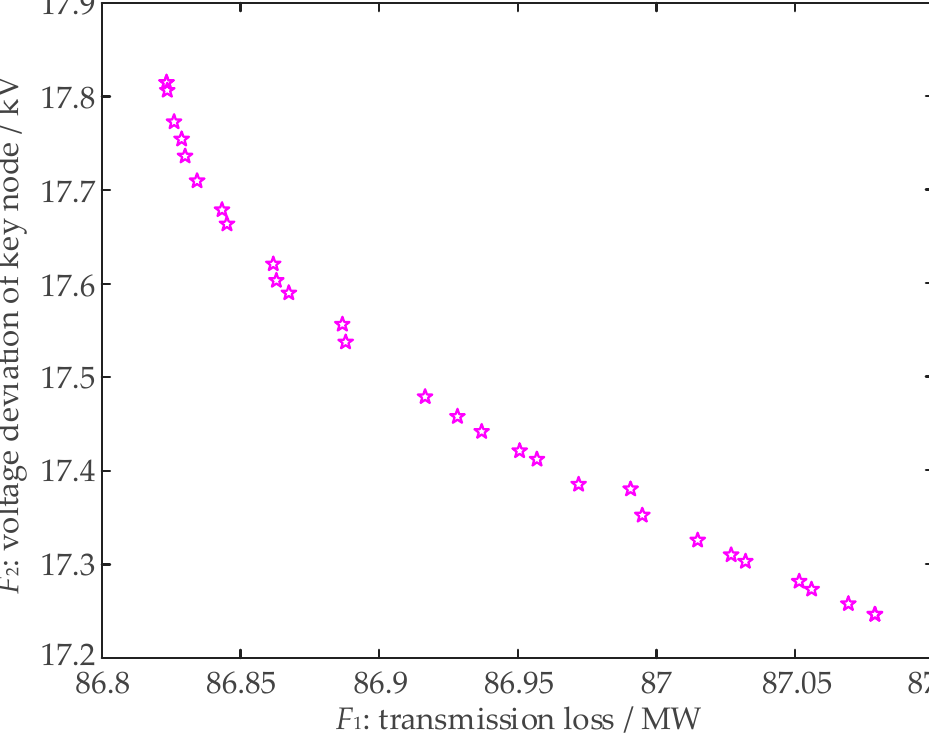
Table 1. Comparison of power loss and voltage variation.